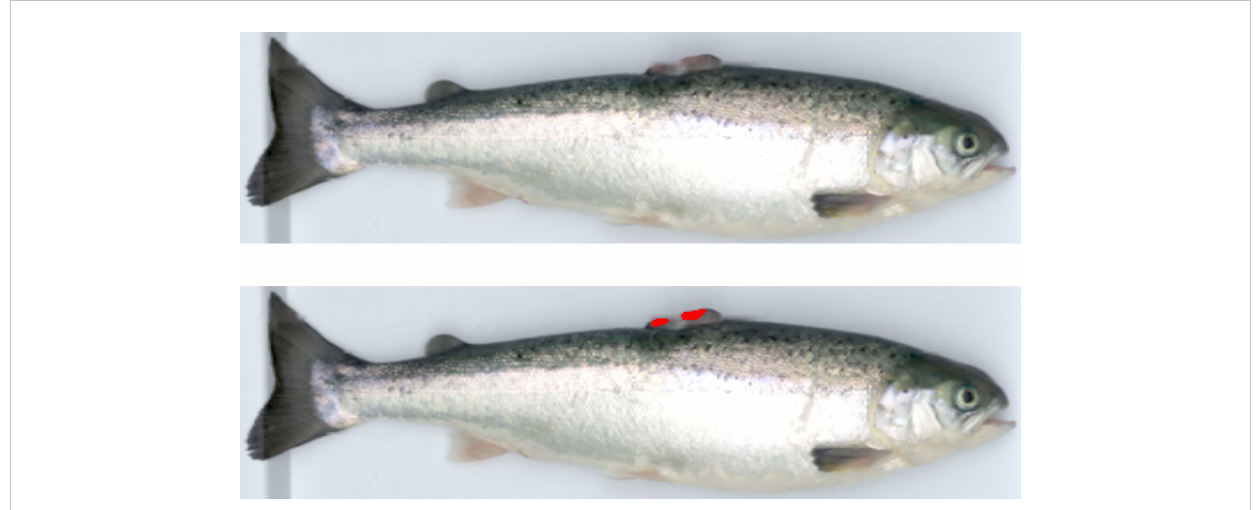
FIGURE 2 An example of the blood analysis for the dorsal fi n. These RGB images were made from CIE RGB colour values calculated from the spectral data (see e.g., Broadbent, 2004). The red areas show the parts of the dorsal fi n where active haemorrhaging was detected from the